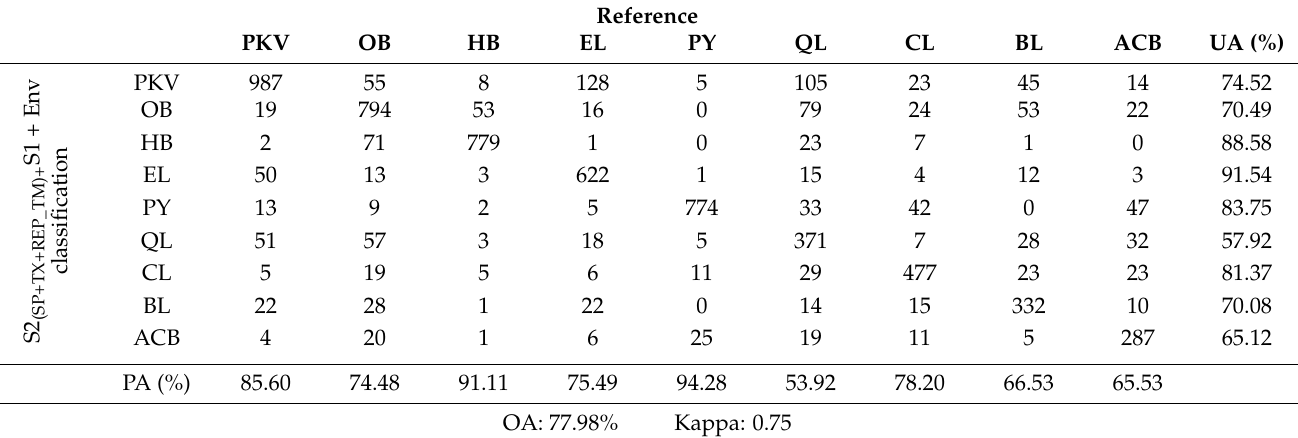
Table A5. Confusion matrix derived using all data..